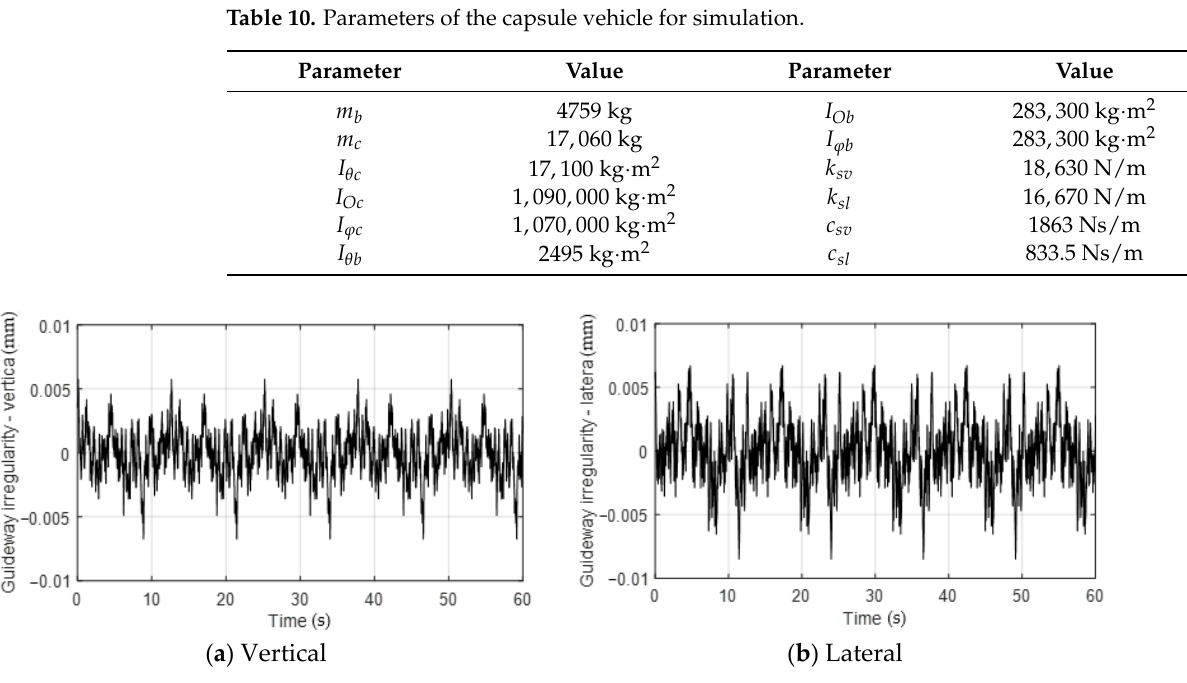
Figure 16. Guideway irregularity in the vertical/lateral direction.